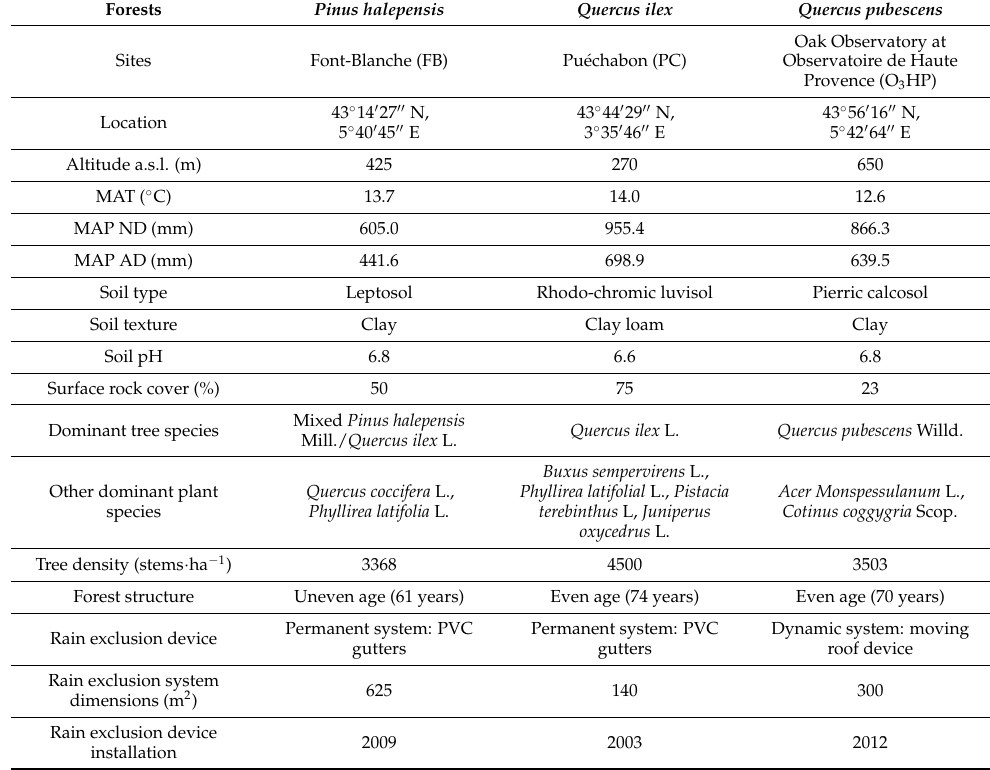
Table 1. Main characteristics of the three studied forests. Mean annual temperature (MAT) and precip- itation (MAP) correspond, respectively, to the annual mean values of temperature and precipitation between 2008 and 2019 in natural precipitation (ND) and amplified drought (AD)